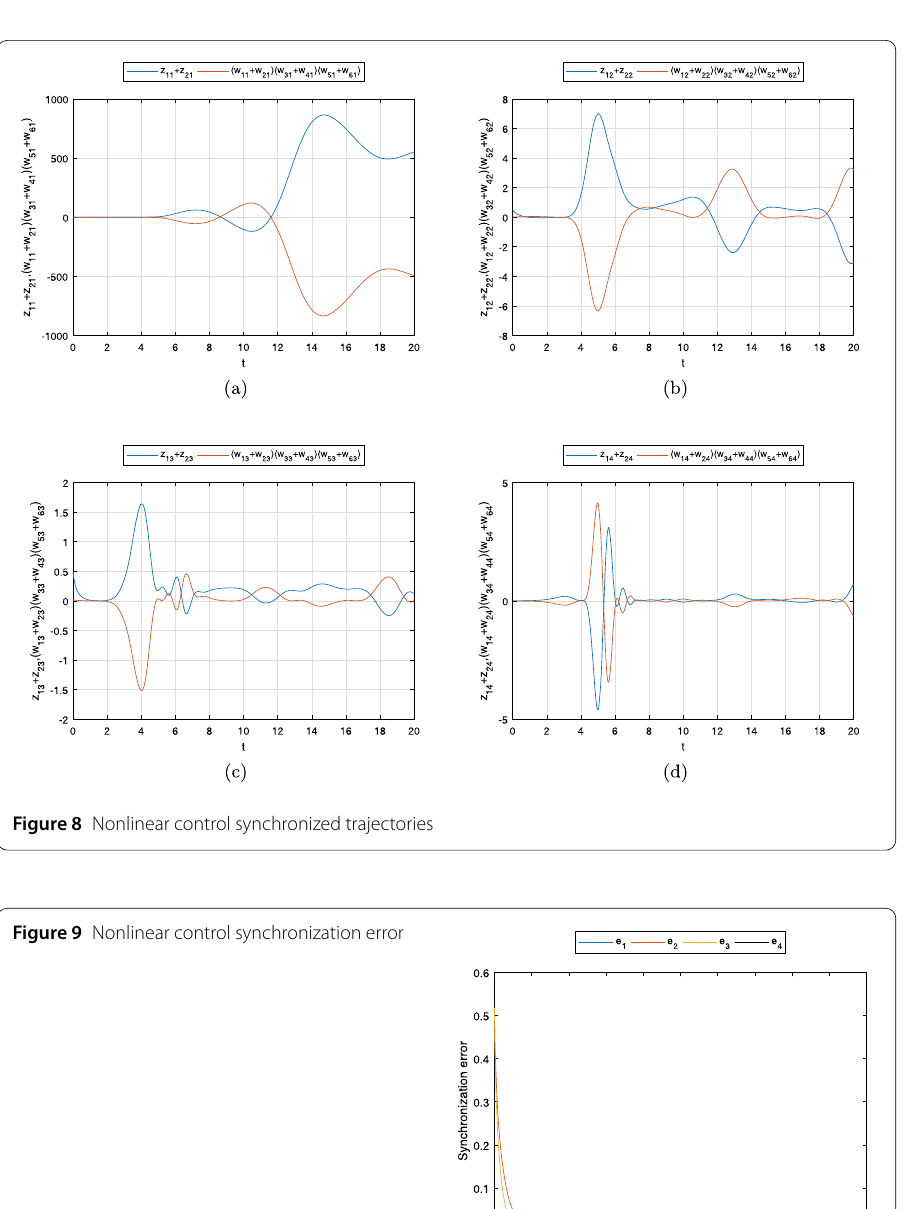
Figure 9 Nonlinear control synchronization